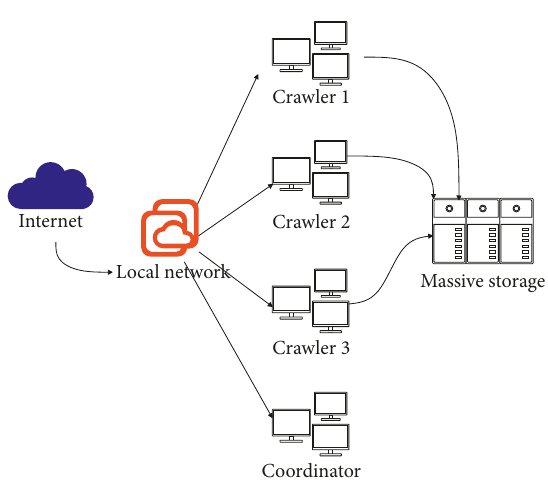
Figure 1: System framework of a distributed